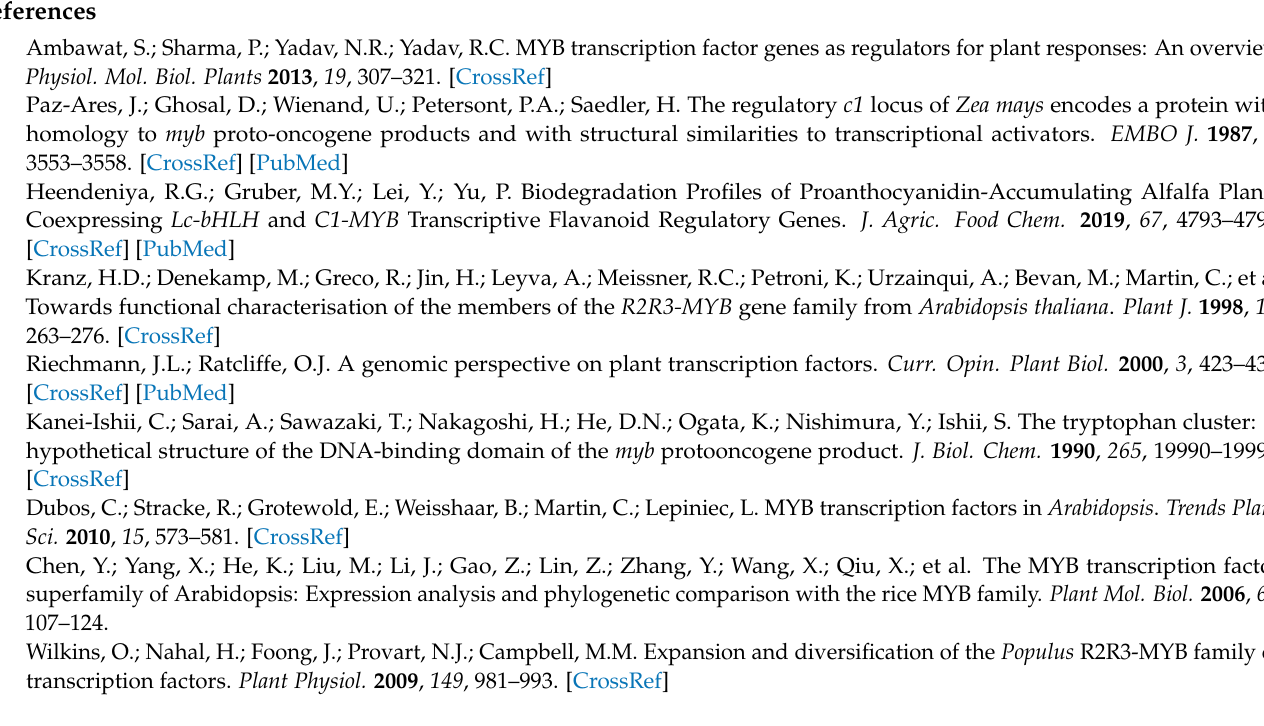
Table S3: List of 131 MYB proteins/genes including 126 R1R2R3-MYBs and 5 R2R3-MYBs in Arabidopsis . Table S4: qRT-PCR analysis of 26 selected HbR2R3-MYB superfamily genes in rubber